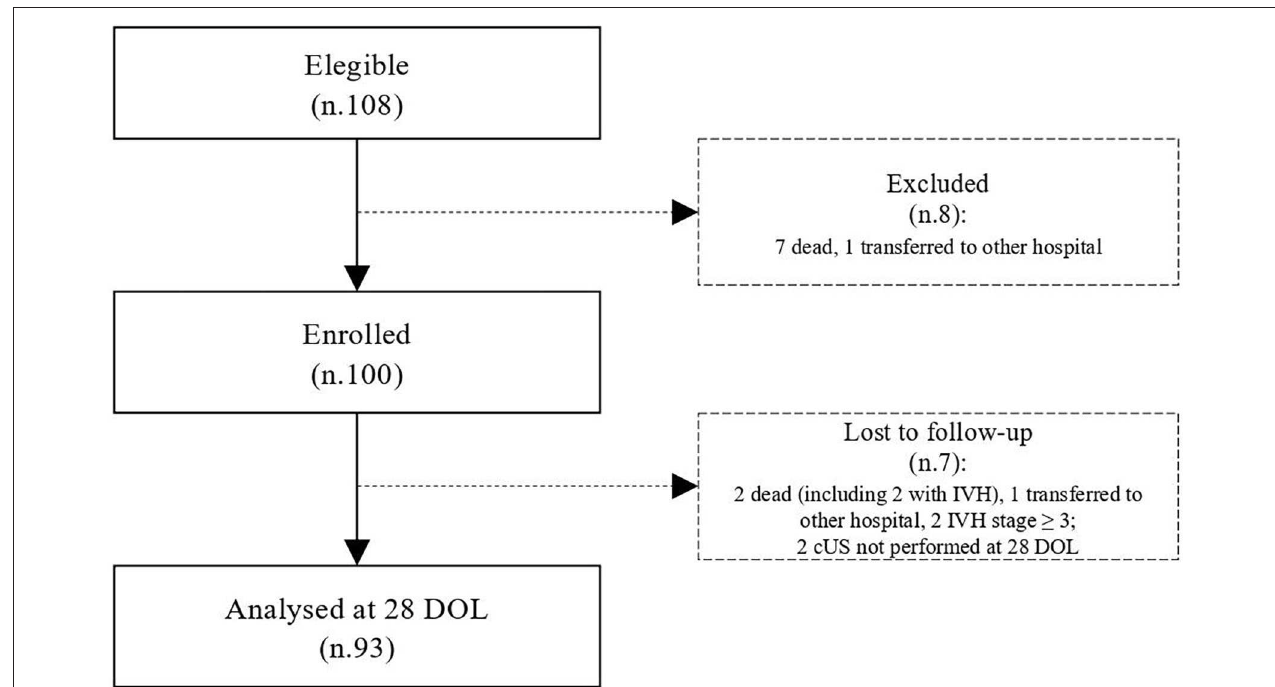
FIGURE 1 | Flow chart. IVH, intraventricular hemorrhage; cUS, cranial Ultrasound; DOL, days of